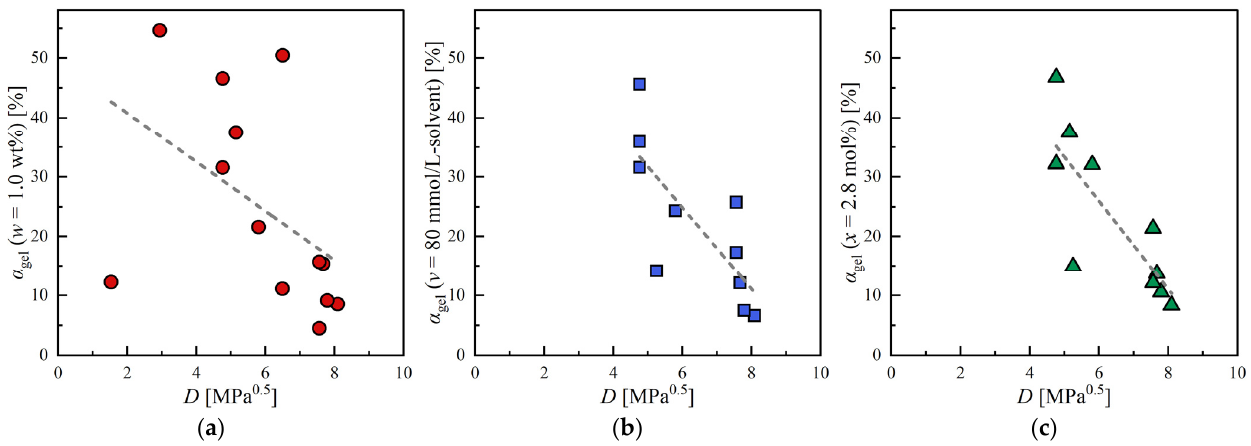
Figure 7. Correlation between light transmittance ( 𝛼 gel ) with the distance in HSP space: ( a ) Fixed concentration at 𝑤 = 1.0% ; ( b ) Fixed concentration at 𝑣 = 80 mmol/L-solvent; ( c ) Fixed concentration at 𝑥 = 2.8 mol%.